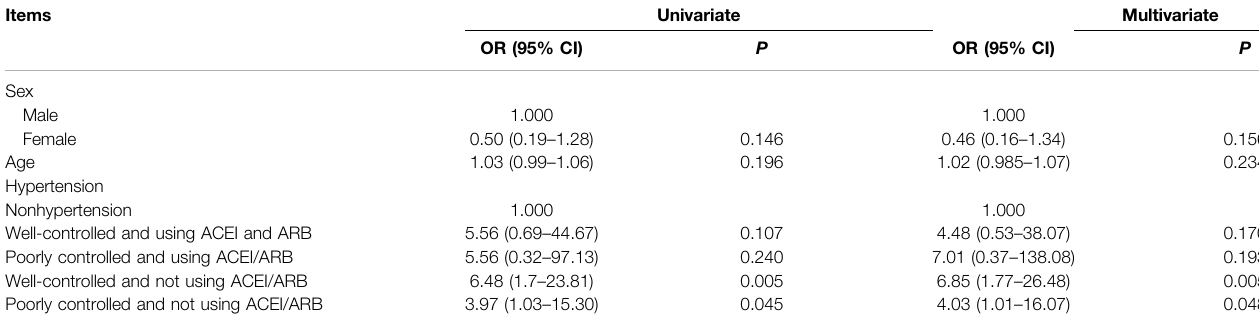
TABLE 3 | Univariate logistic regression analysis and multivariate logistic regression analysis of severity of COVID-19-related factors. Items